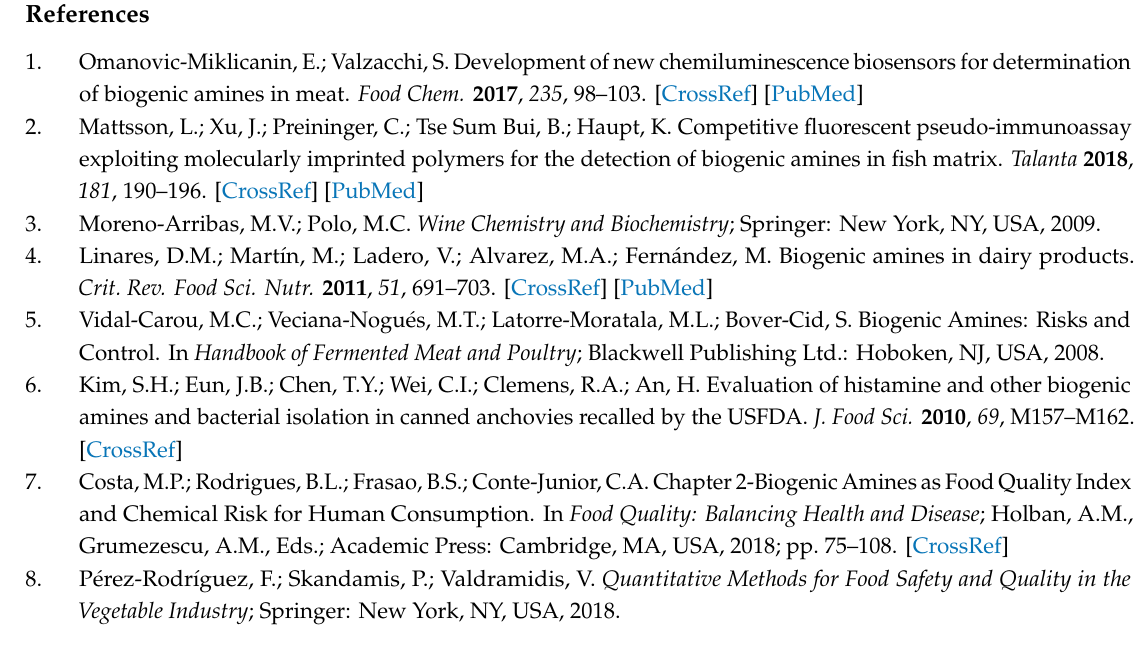
Table S1. Individual BA and wine parameters in 81 wine samples from Hexi Corridor Region ( n =